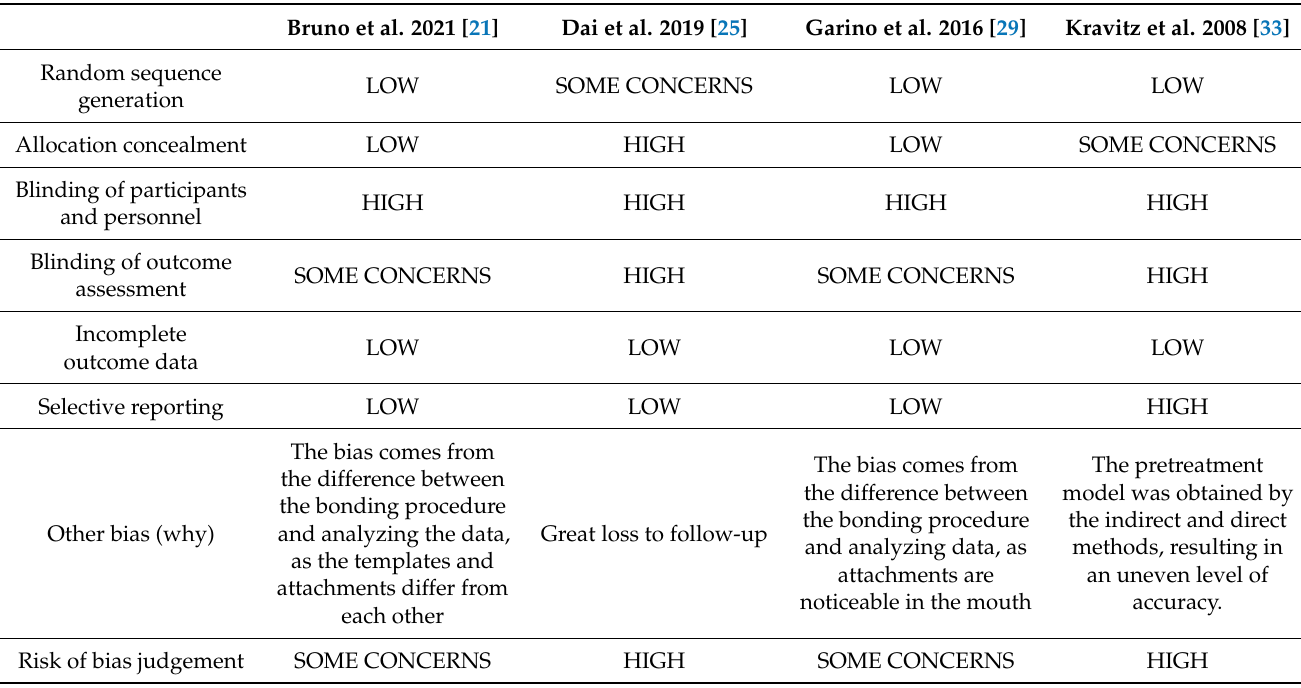
Table 5. Evaluation of included studies according to Cochrane Risk of Bias Tool for Randomized Controlled Trial.